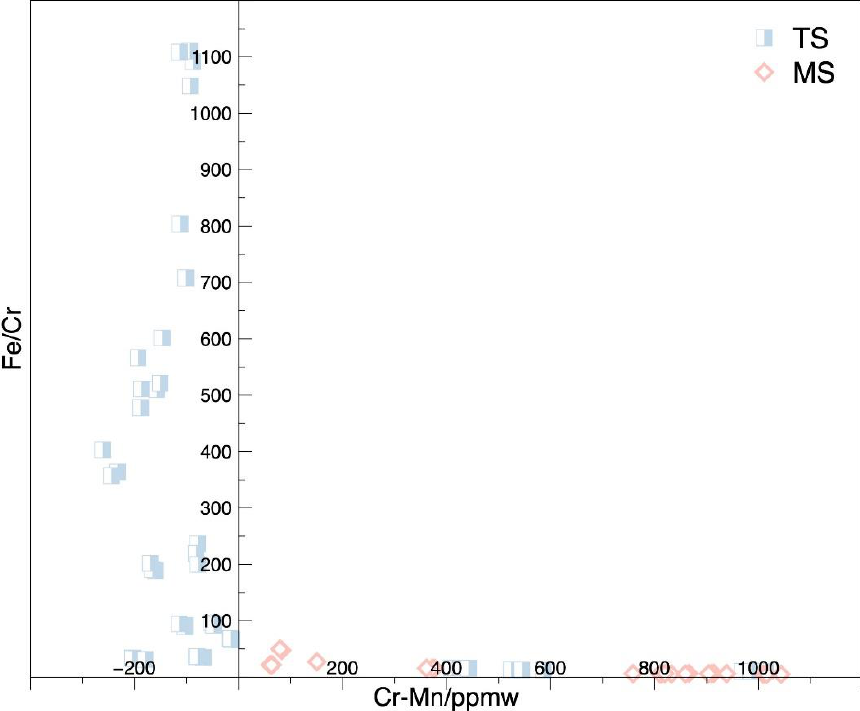
Figure 11. The scatter diagram plots Cr-Mn vs. Fe/Cr for purple spinels from Tanzania and Myan-